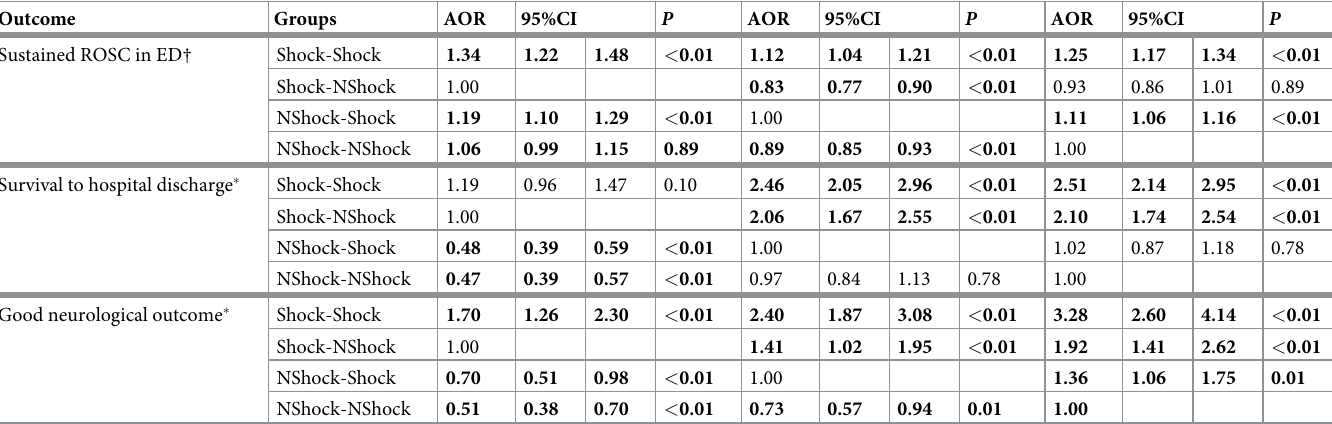
Table 2. Multivariate logistic regression for survival to hospital discharge and good neurological outcome at hospital discharge. Outcome Groups Sustained ROSC in ED†